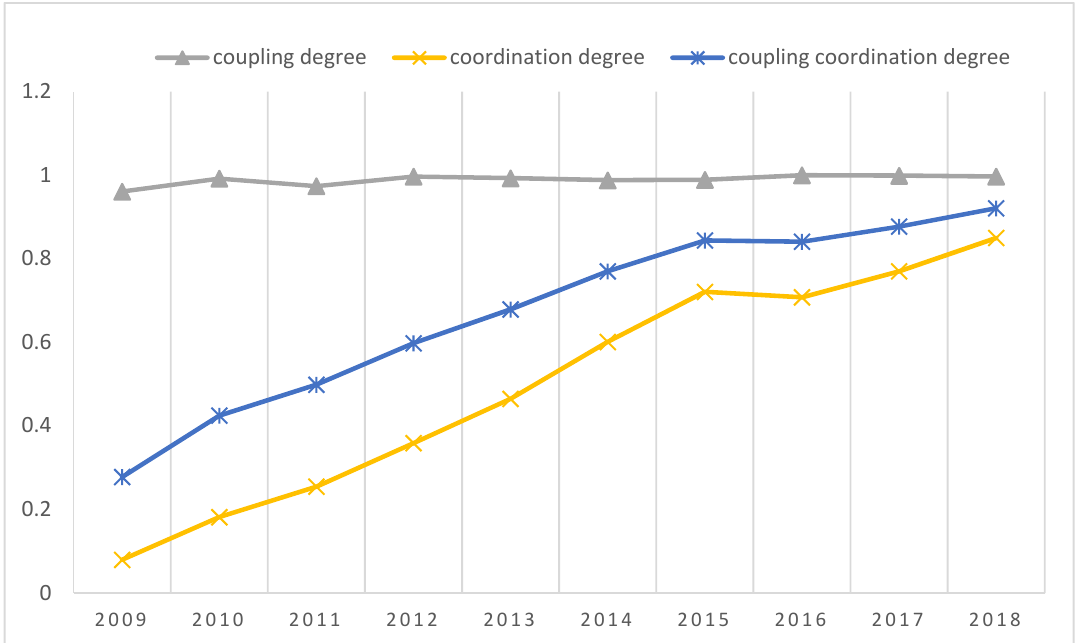
Figure 1. Development trend of the agriculture industry and the tourism industry.